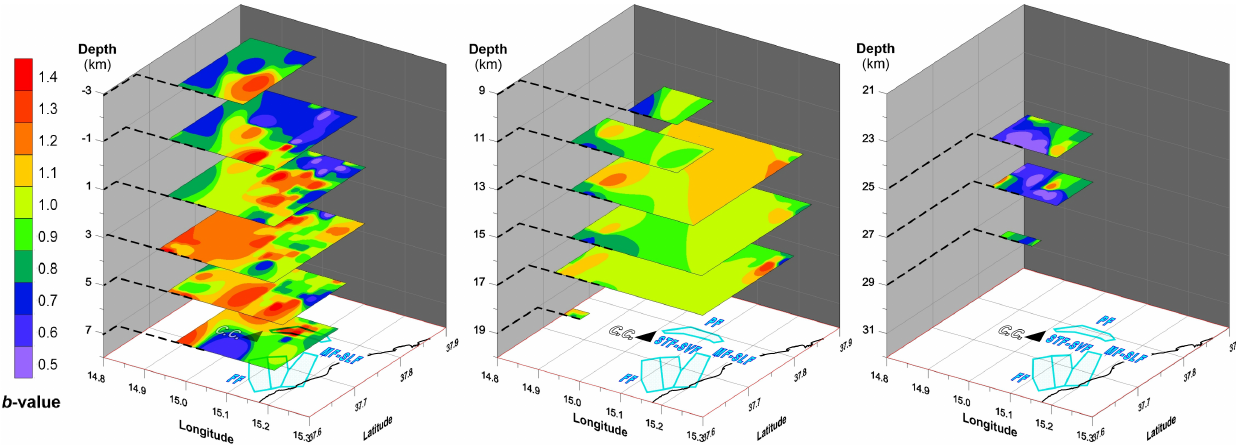
Figure 8. Distribution of the b values beneath Etna calculated from the instrumental earthquake catalogue (2005–2015): the horizontal sections show the grids at different